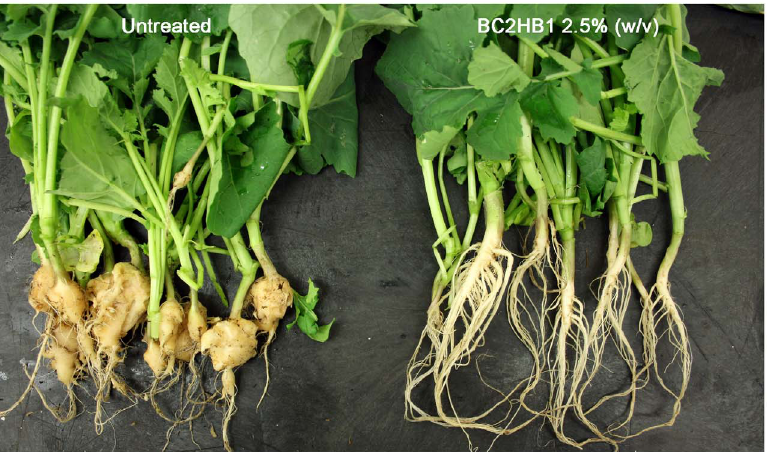
Figure 1. The plants on the right illustrate suppression of clubroot on canola by a granular formulation of Heteroconiumchaetospira BC2HB1 incorporated into the planting mix at 2.5% (w/v). Plants on the left are from an untreated control. Each plant was inoculated with a suspension of Plasmodiophora brassicae resting spores at 2 6 10 5 spores pot 2 1 immediately after seeding.